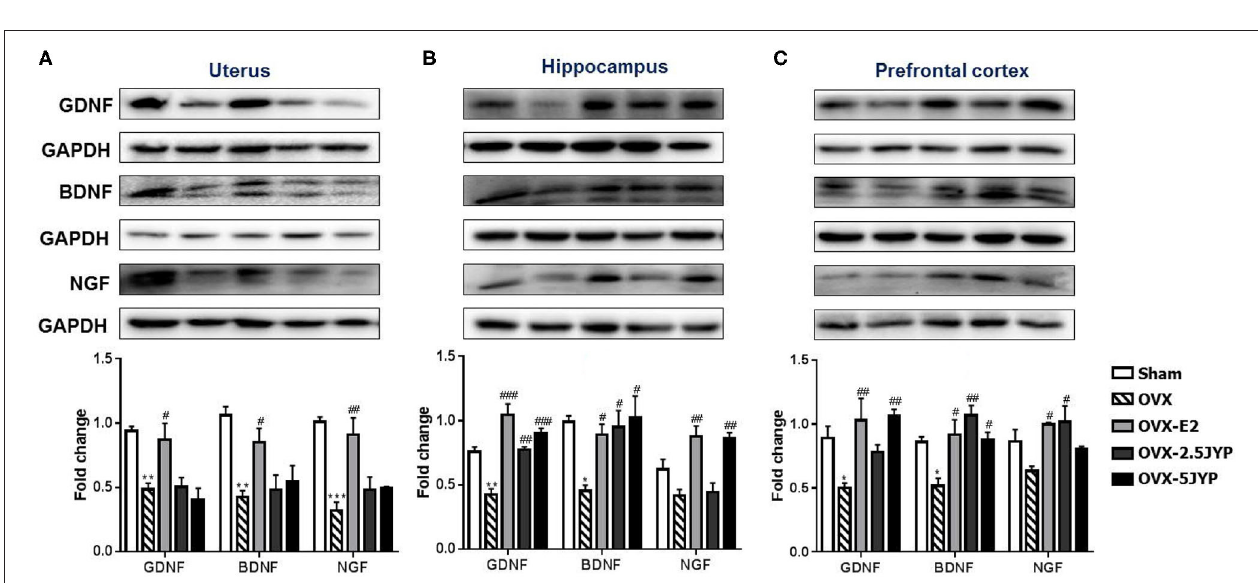
FIGURE 9 | Effects of 2.5 g/kg JYP (2.5 JYP), 5.0 g/kg JYP (5 JYP), and 0.3 mg/kg estradiol (E2) on the expression of glial cell-derived neurotrophic factor (GDNF), brain-derived neurotrophic factor (BDNF), and nerve growth factor (NGF) in the uterus (A) , hippocampus (B) , and prefrontal cortex (C) . Data are expressed as mean ± SEM ( n = 3) and examined using one-way analysis of variance (ANOVA), followed by post hoc between-group comparisons: * P < 0.05, ** P < 0.01, vs. sham group; # P < 0.05, ## P < 0.01, ### P < 0.001 vs. vehicle group.